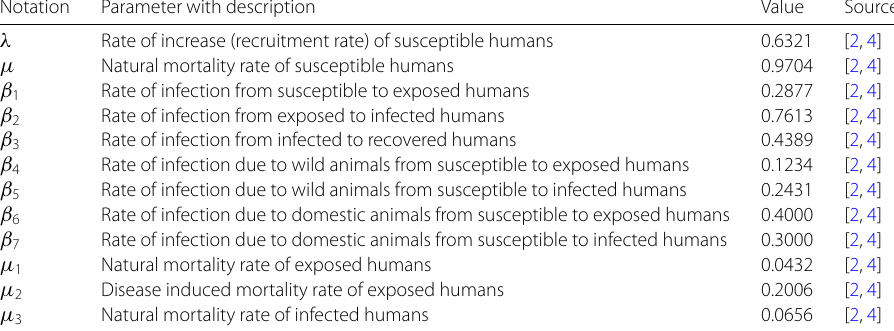
Table 1 Summary of constant parameters and their numerical values appearing in the epidemic